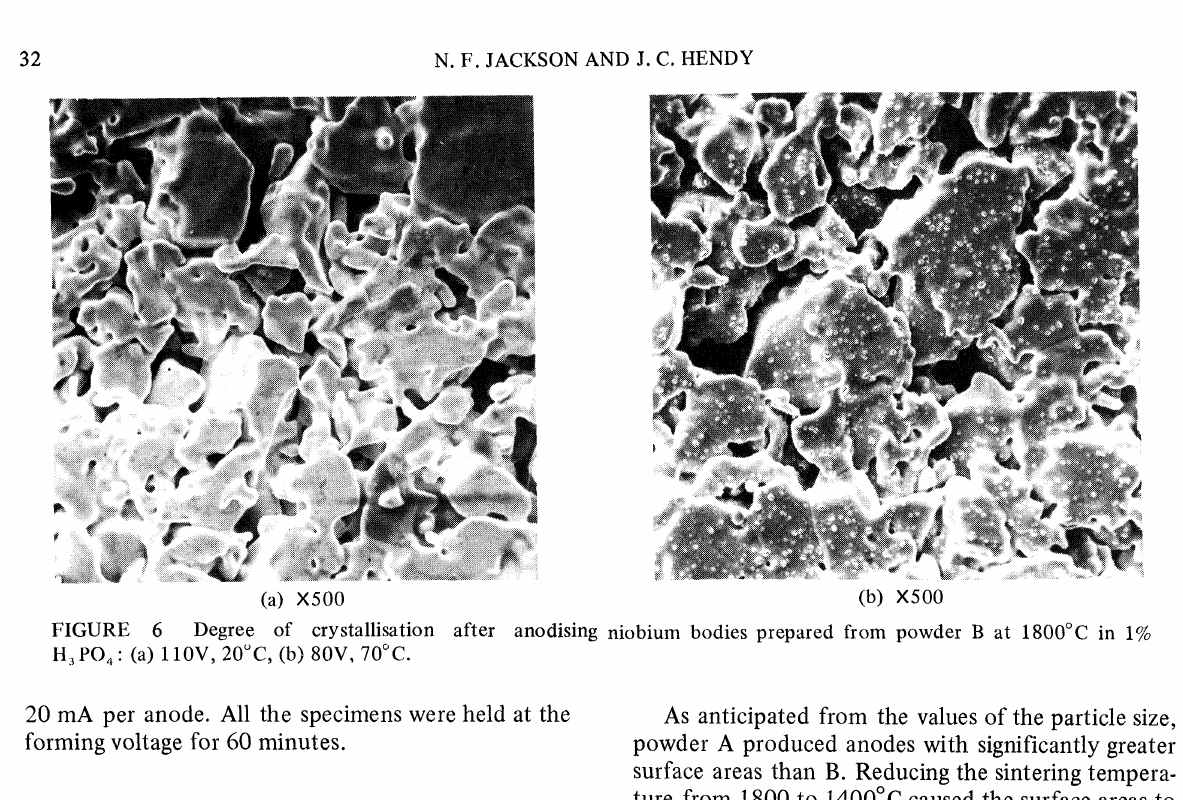
Degree of crystallisation after anodising niobium bodies prepared from powder B at 1800C in 1% H3PO" (a) ll0V, 20C, (b) 80V, 70C. 20 mA per anode. All the specimens were held at the forming voltage for 60